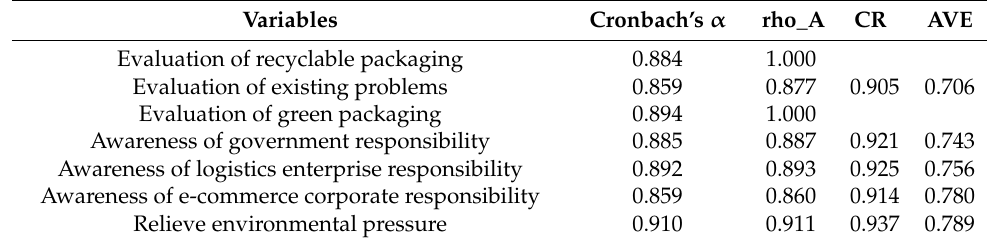
Table 13. Results of reliability and validity